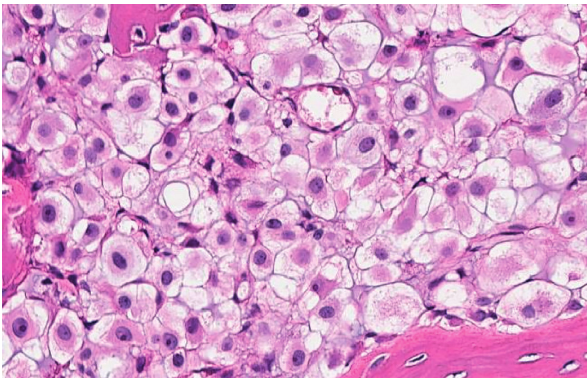
Figure 5: Clear cell chondrosarcoma. Cells show distinct borders, abundant cytoplasm, and central nuclei. These cells are located within the femoral head, with normal bone visible on this specimen.